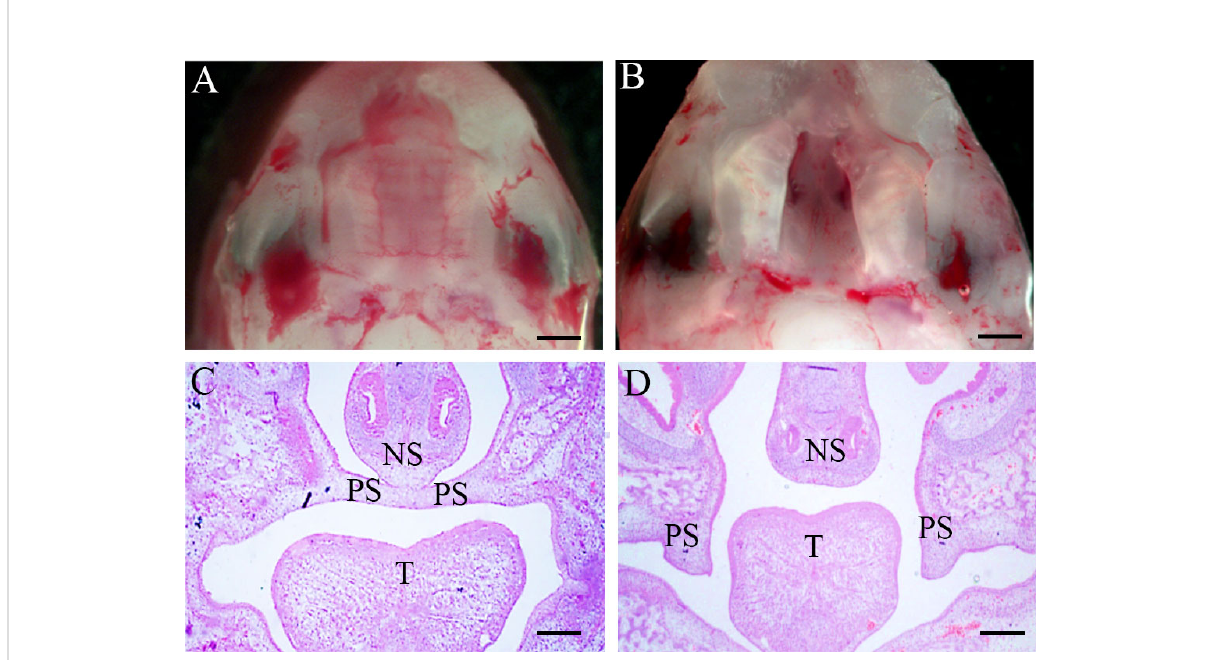
FIGURE 1 Morphology and H&E of palate shelf tissues at E16.5. (A, C) The palatal shelf contacted the midline and fused through the formation of the midline epithelial seam (MES) in the mid-anterior region of a control embryo. (B, D) Unfused, separated palatal shelf from an embryo of RA- treated mouse. (A, B) Morphological specimens (magni fi cation ×100, scale bar 100 m m); (C, D) , H&E staining results (magni fi cation ×40, scale bar 200 m m). PS, palatal shelf; T, tongue; NS, nasal septum; H&E, hematoxylin, and